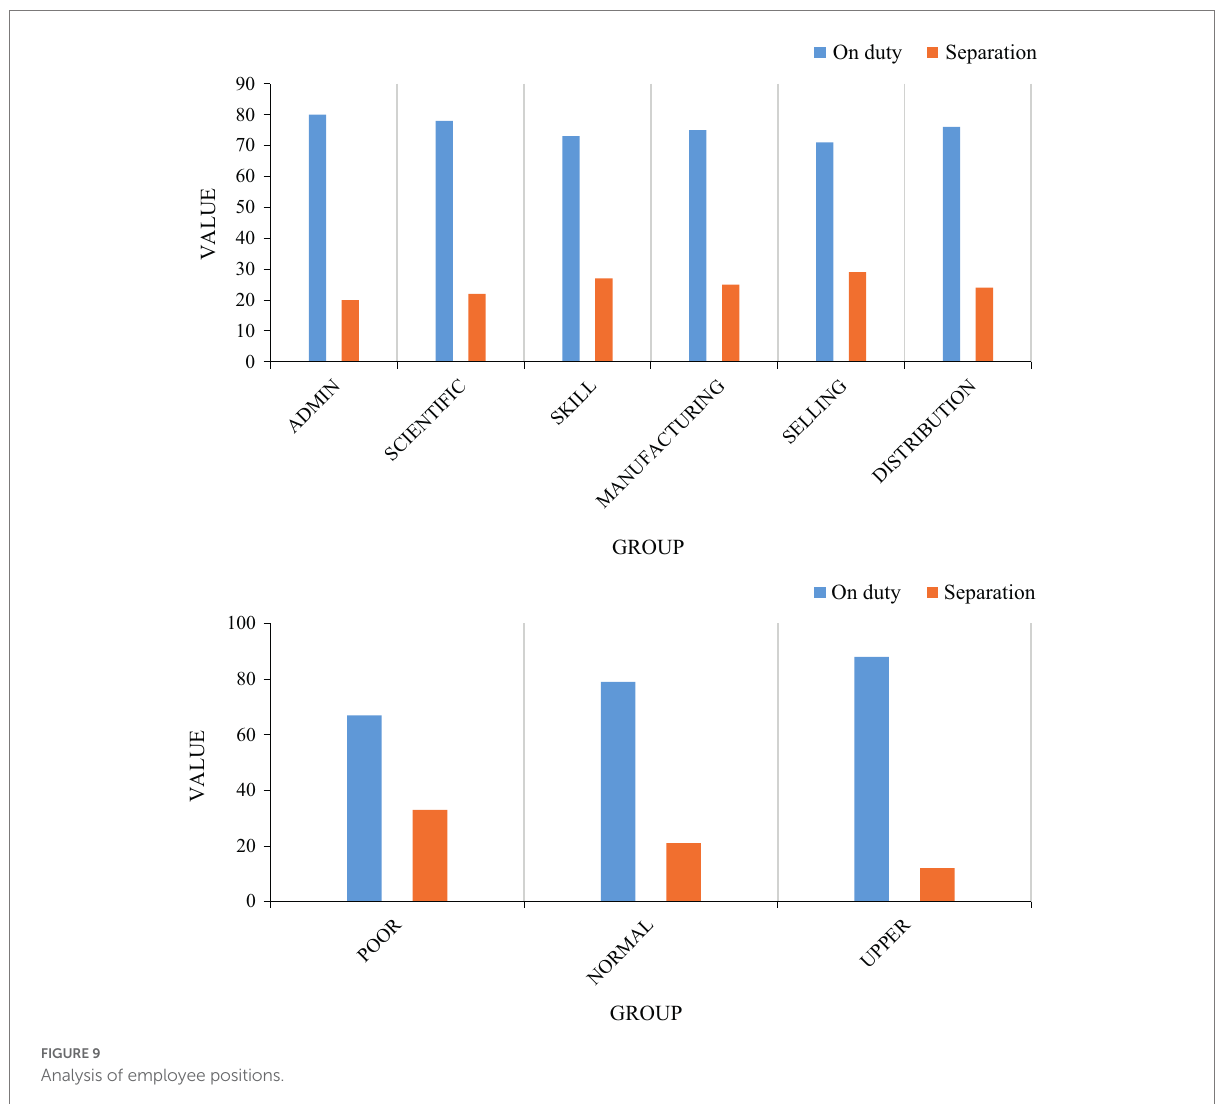
FIGURE 9 Analysis of employee